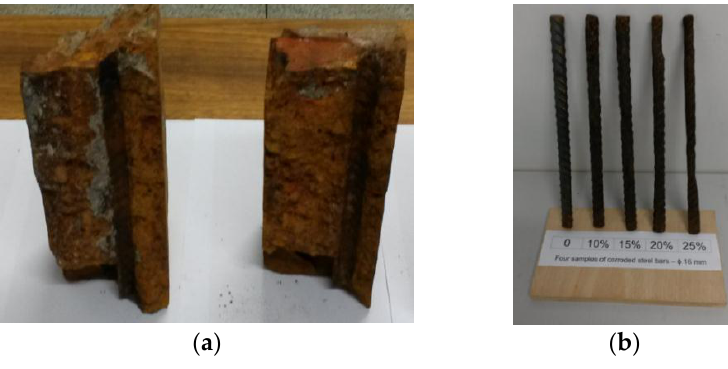
Figure 10. ( a ) Concrete debris; ( b ) Samples of corroded steel bars.